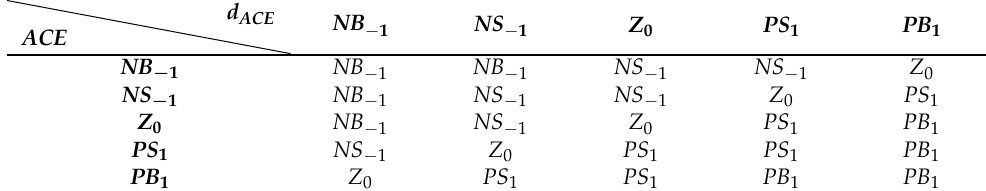
Table 1. Rule structure for the Fuzzy-PSO